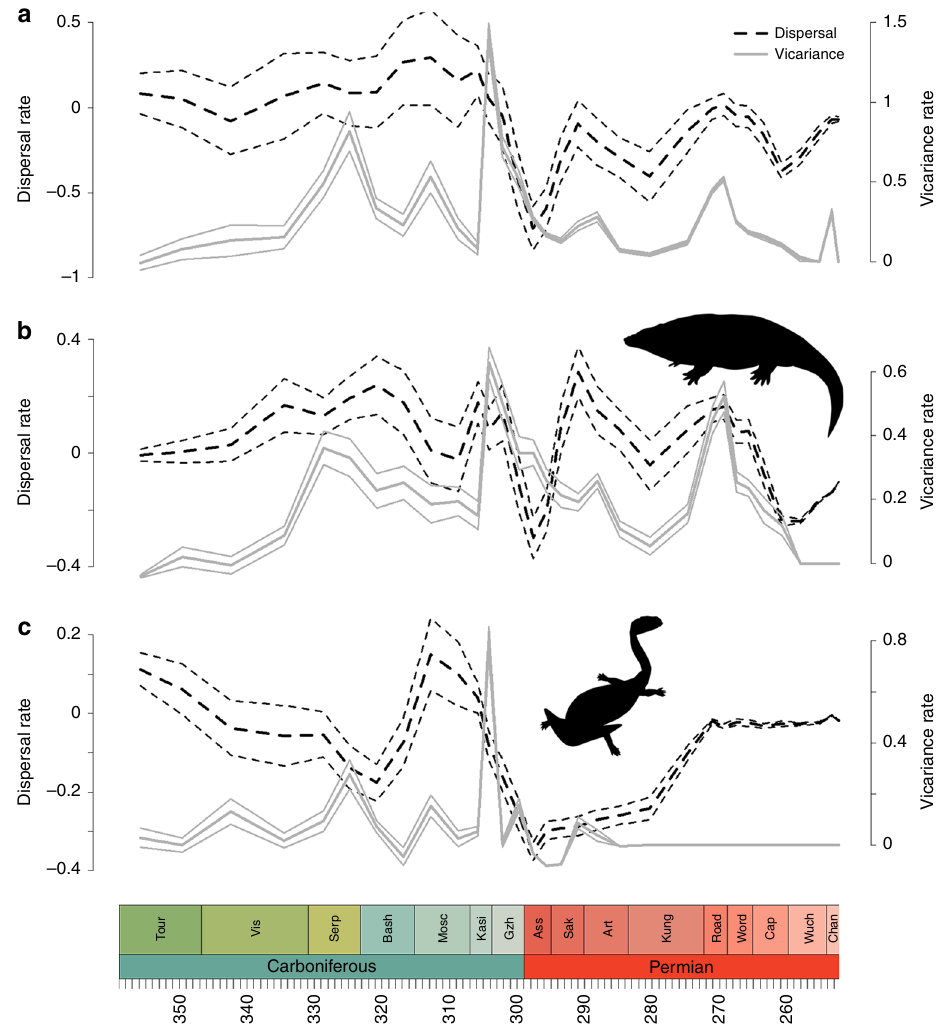
Fig. 2 Dispersal and vicariance rates of amphibian clades through time. a All amphibians; b Temnospondyli; c Lepospondyli. Solid grey lines represent vicariance. Dashed black lines represent dispersal. Thick lines represent the mean of the rates obtained from each stochastic mapping iteration. The thinner lines represent a standard error above and below. Silhouettes from phylopic.org. b Eryops , by Dmitry Bogdanov (vectorized by T. Michael Keesey),